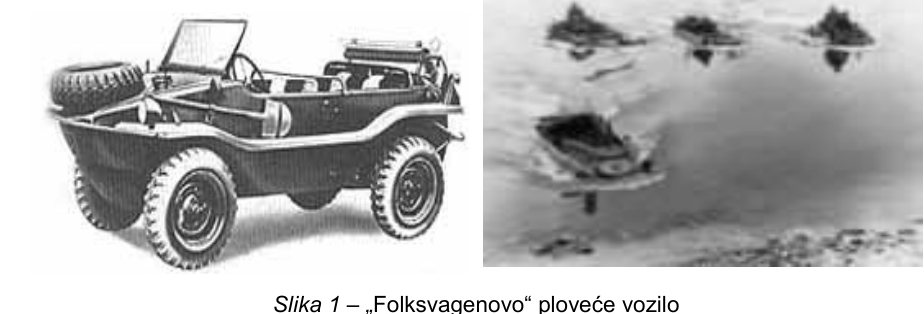
Figure 1 – VW-Schwimmwagen amphibious